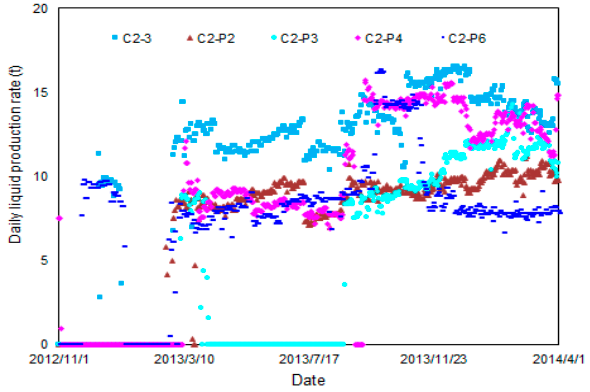
Figure 37. Daily liquid production curve of the effective wells .